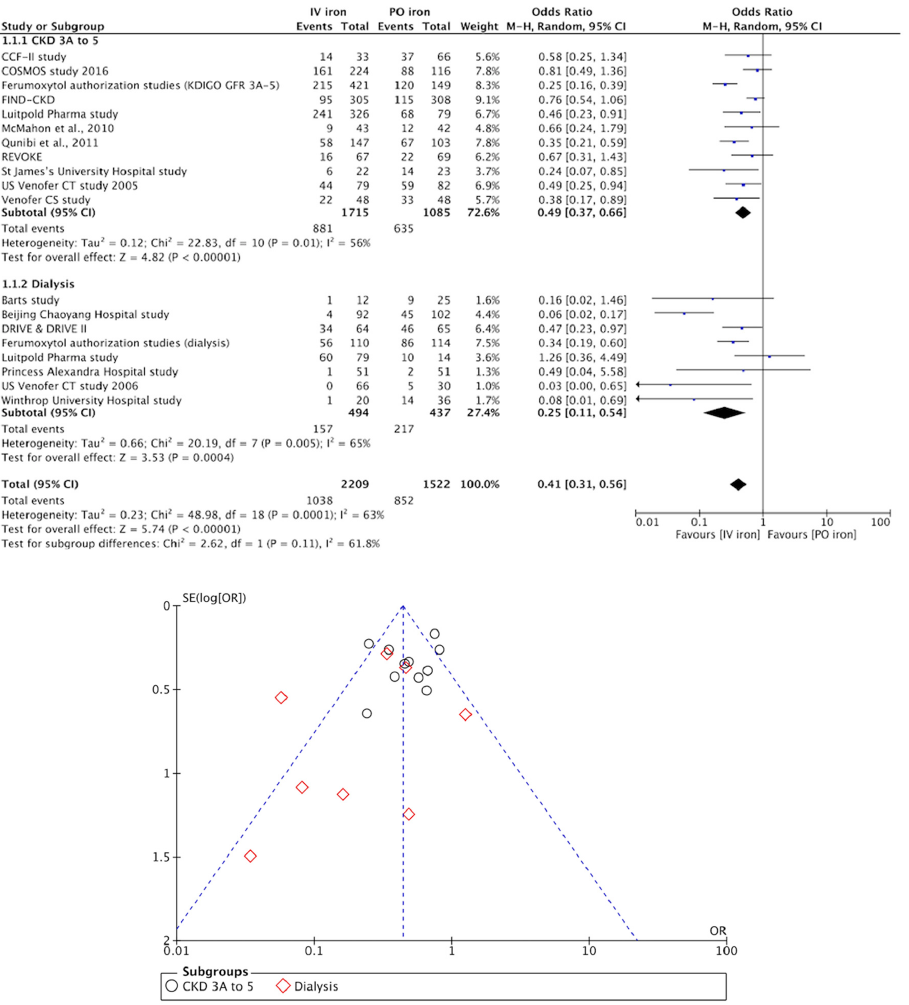
Figure 2. Forest and funnel plots showing effect estimates of IV versus PO iron supplements in the two subgroups conformed. CI, confidence interval; IV, intravenous; M-H, Mantel–Haenszel test; PBO, placebo; PO, per os; SE, standard error.